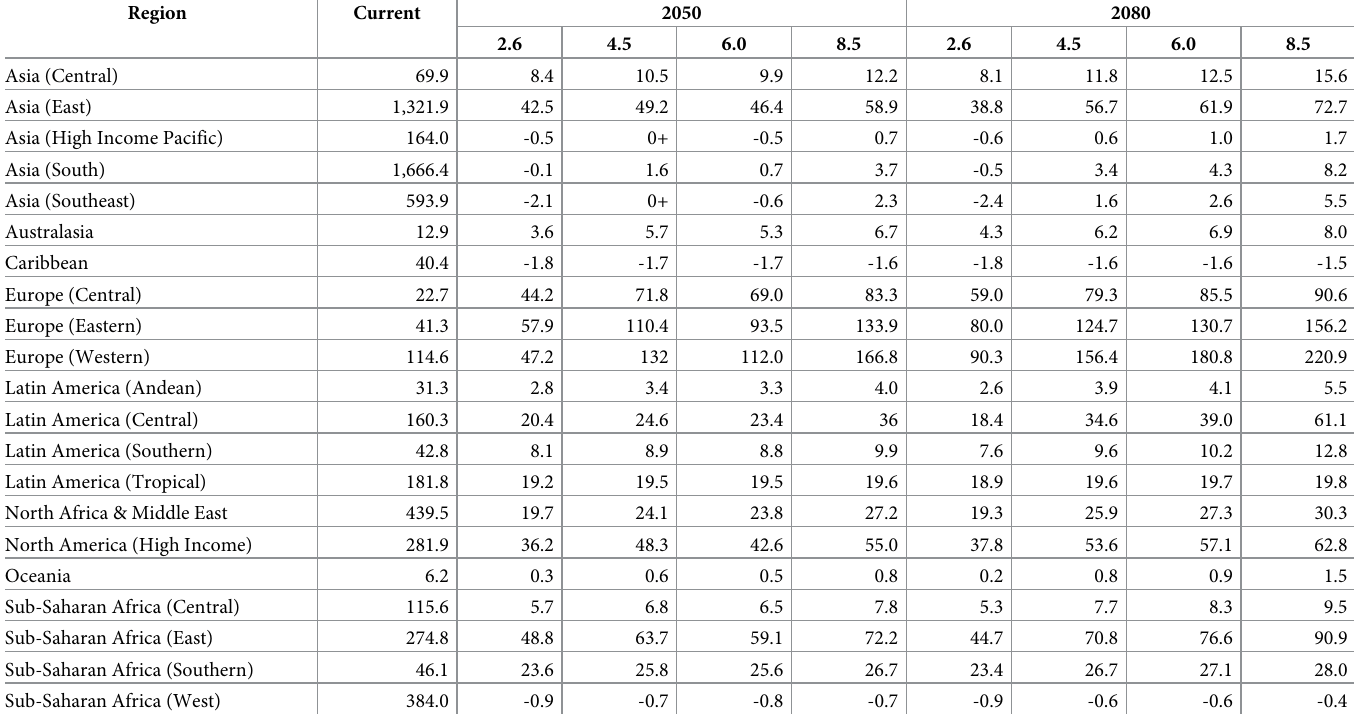
Table 1. Changing population at risk due to temperature suitability for Aedes aegypti virus transmission. All values are given in millions; future projections are aver- aged across GCMs, broken down by year (2050, 2080) and RCP (2.6, 4.5, 6.0, 8.5), and are given as net change from current population at risk. 0+/0- denote the sign of smaller non-zero values that rounded to 0.0, whereas “0” denotes true